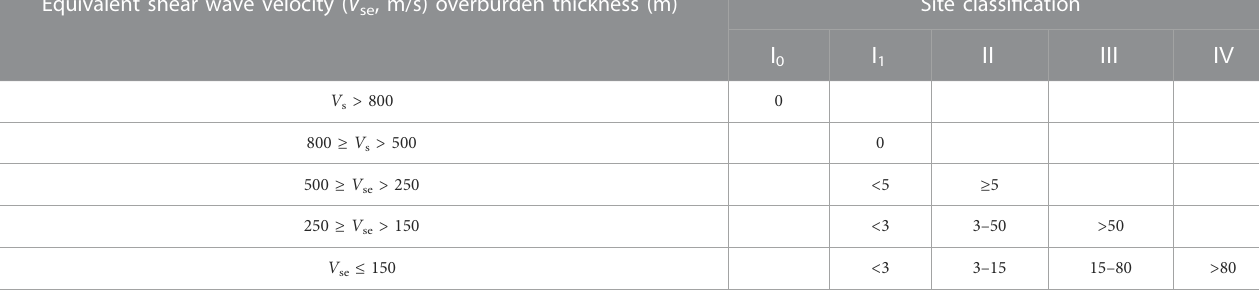
TABLE 1 The criteria for site classi fi cation. Equivalent shear wave velocity ( V se , m/s) overburden thickness (m)